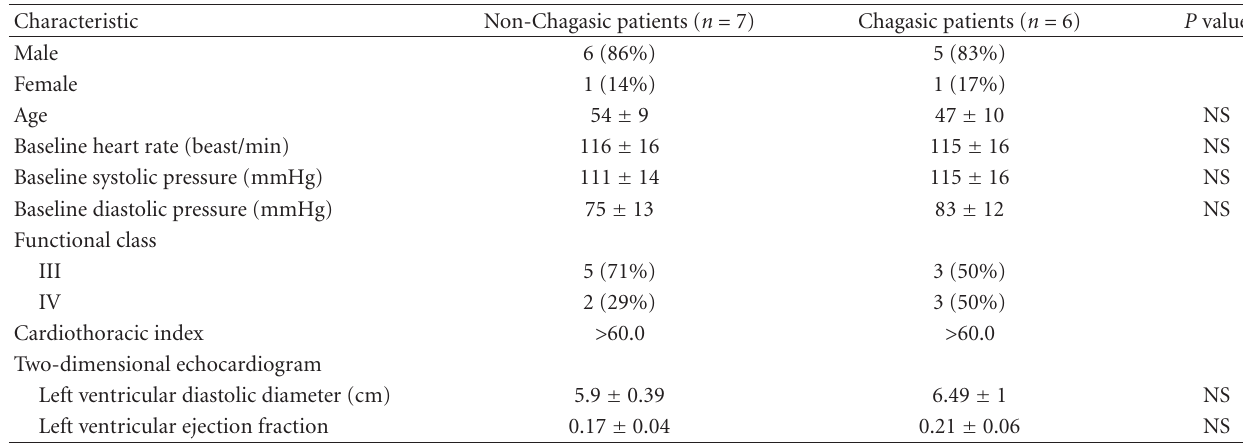
Table 1: Clinical, radiologic, and echocardiographic characteristics of non-Chagasic and chagasic patients with advanced systolic heart failure. There was no di ff erence in the baseline heart rate, blood pressure, and functional class (NYHA). The degree of ventricular dysfunction and dilatation was also similar in both groups of patients (see [36], with permission from Elsevier). Characteristic